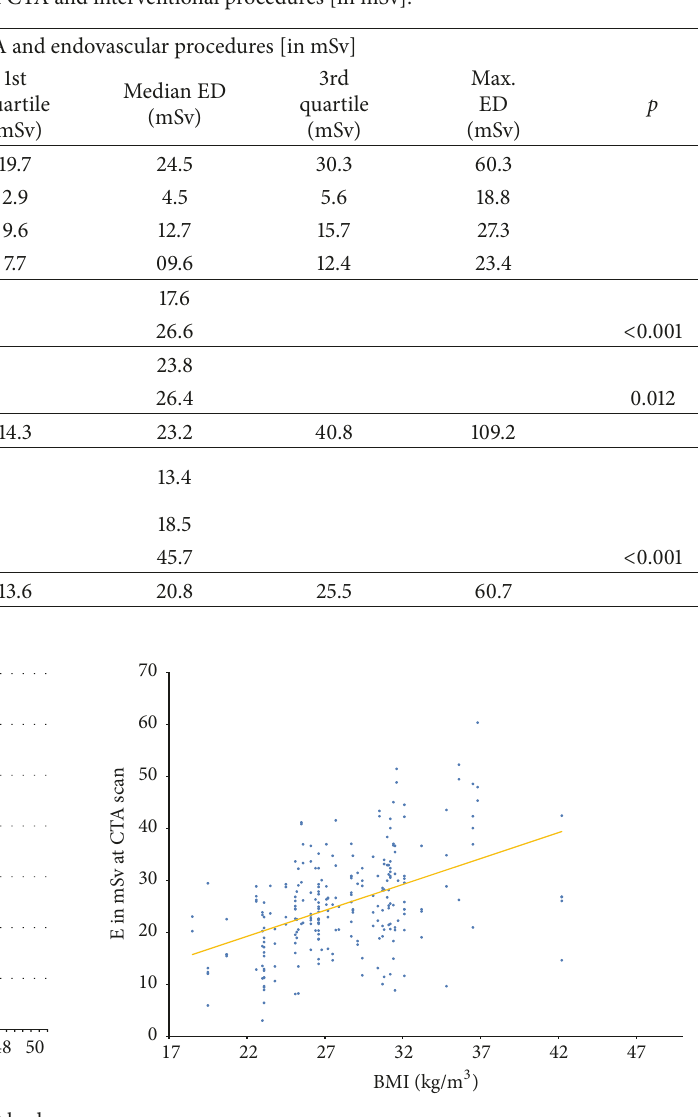
Figure 2: Correlation between ED from CTA [in mSv] and body mass index [in